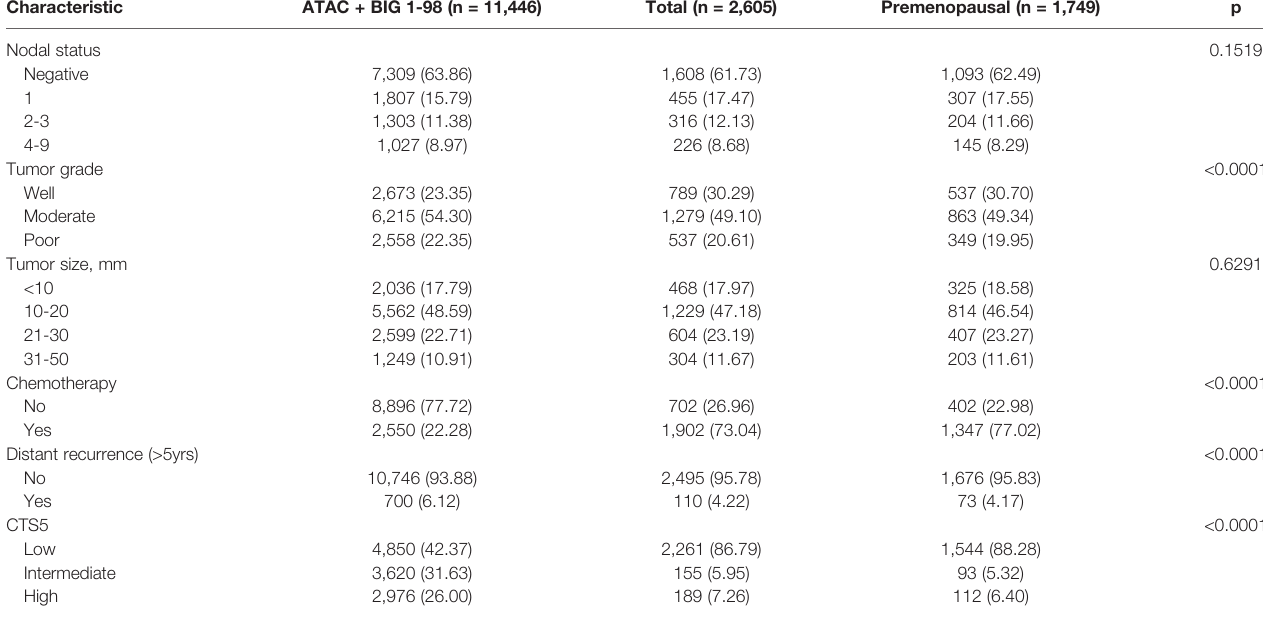
TABLE 3 | Comparison of combined ATAC and BIG 1-98 cohorts and the present cohort.